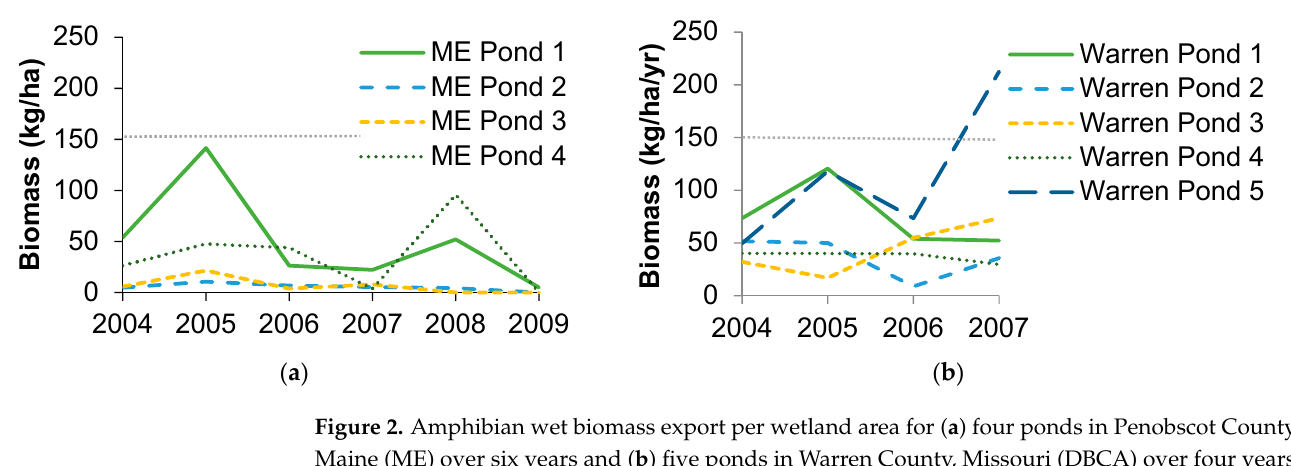
Figure 1. Total amphibian wet biomass export for ( a ) four ponds in Penobscot County, Maine (ME) over six years, ( b ) five ponds in Warren County, Missouri (DBCA) over four years, and ( c ) three ponds in Boone County, Missouri over two to three years (ponds 1 and 2: Baskett Wildlife Area, edge pond: Mark Twain National Forest).